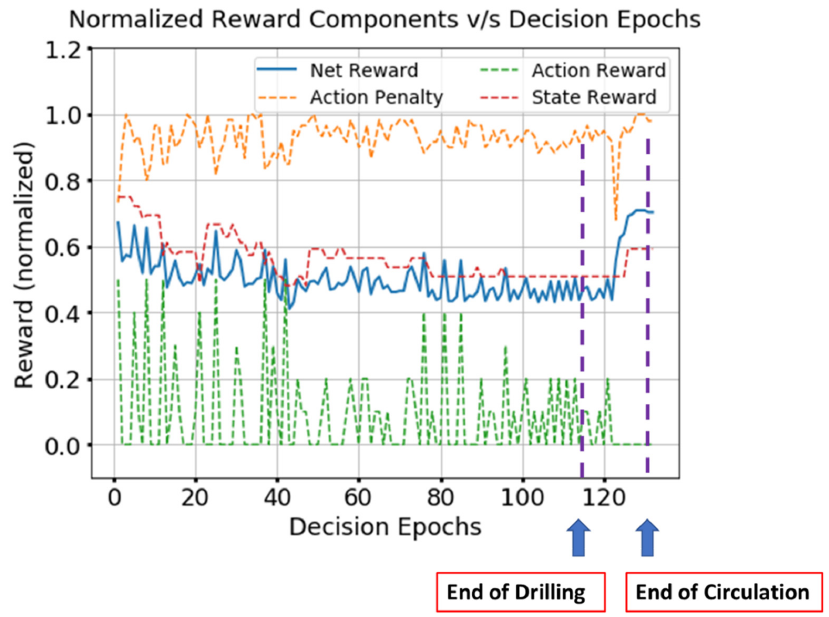
Figure 14 overlays the different normalized reward components calculated for decision epoch intervals of 5 min. For this system, the net reward tracks the state reward, since W s _ norm is significantly higher than the other weights. The reward value at the end of the drilling operation stabilizes to around 0.46. An increase in reward value to 0.68 at the end of the circulation cycle indicates an improvement in the hole condition. This improvement is also reflected in the state reward value, which increases from 0.51 to 0.59.